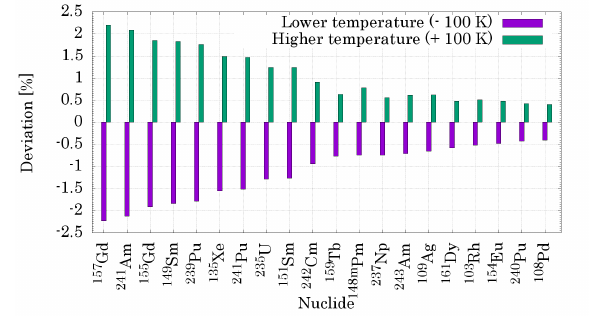
Figure 4. Effect of change in fuel temperature on